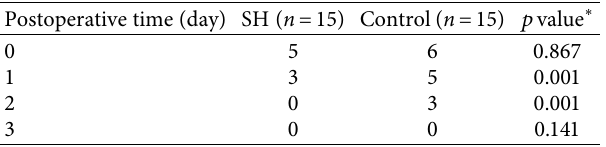
Table 2: The medians of pain score assessed by VAS immediately after operation (Day 0) and on Days 1, 2, and 3 between the SH and the control